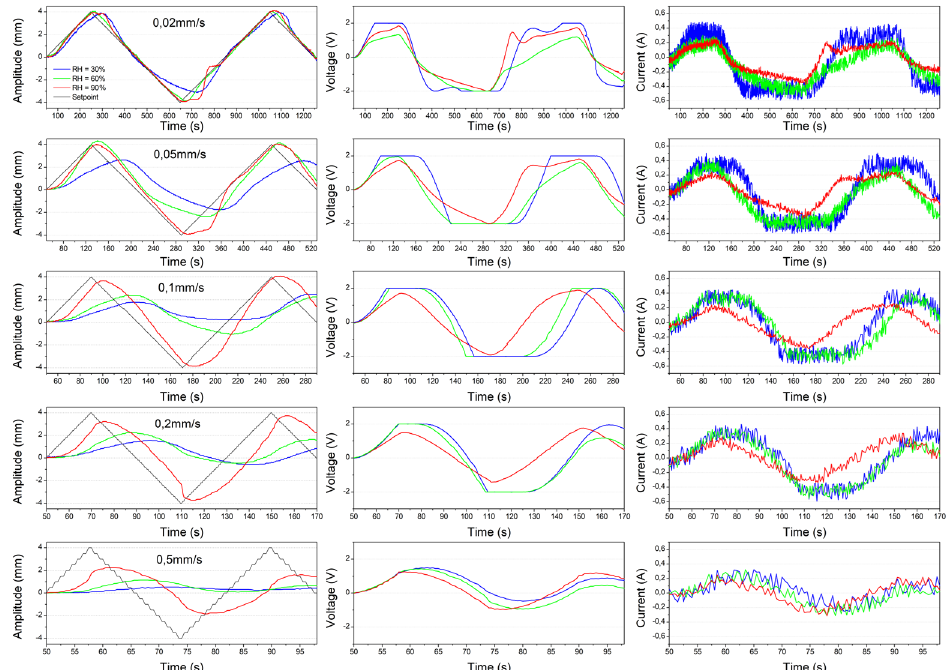
Figure 7. IPMC electromechanical response as a function of Time for a bi-directional non-sinusoidal triangular waveform